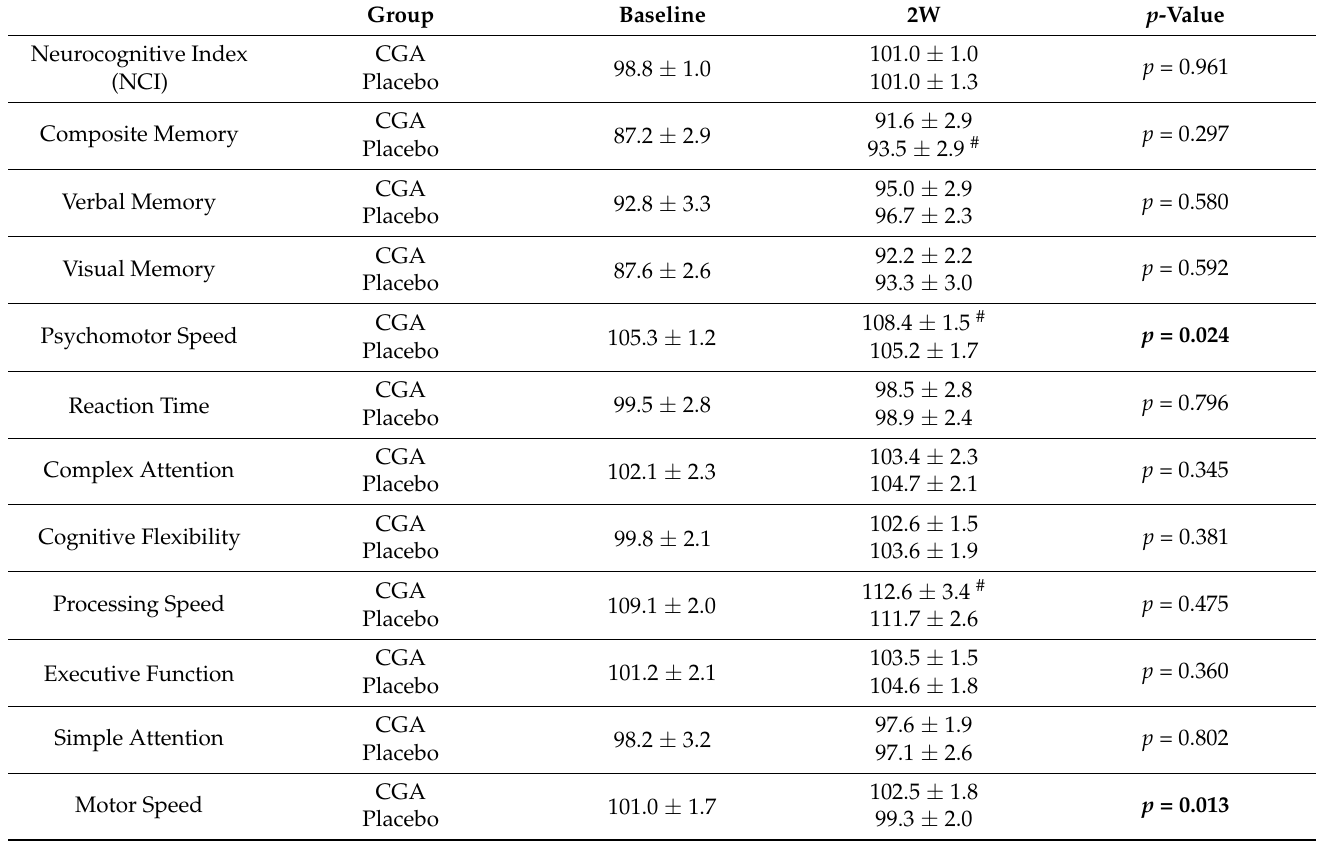
Table 4. Standardized scores of individual tests in